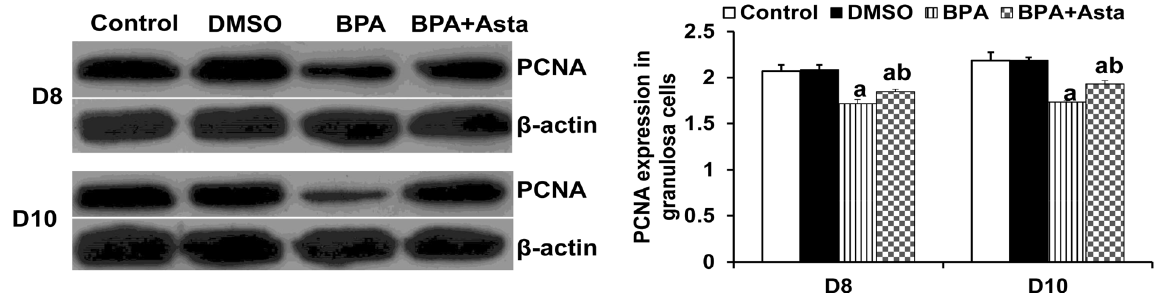
Figure 3. PCNA expression levels in granulosa cells. The expression levels of PCNA in D8 and D10 follicular granulosa cells were detected with Western blot analysis. Compared with control, a P < 0.05; and compared with BPA group, b P <